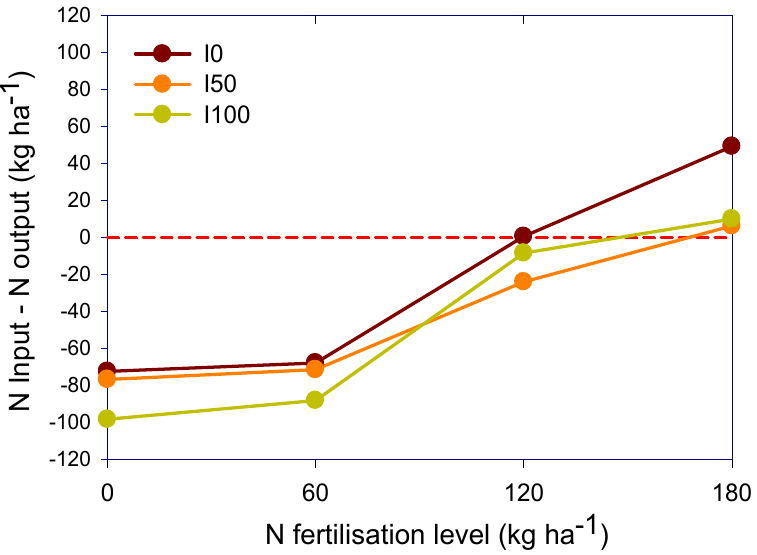
Figure 8. Apparent N soil balance (input—output) in sweet sorghum cv. Keller compared to the irrigation level (I0, I50, I100 = 0, 50, 100% ETc, respectively).